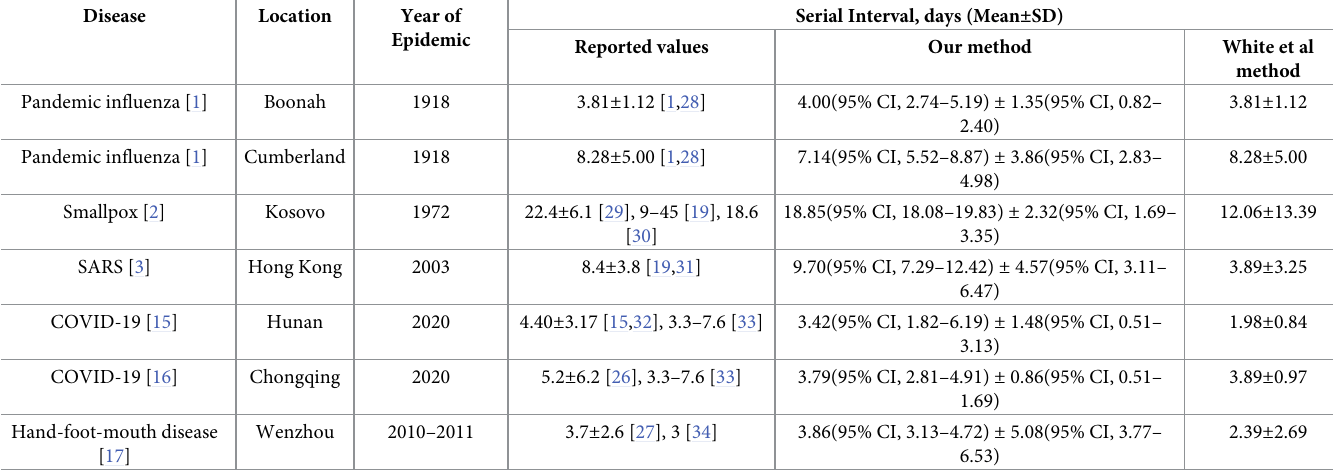
Table 2. Historical epidemics and their serial interval.